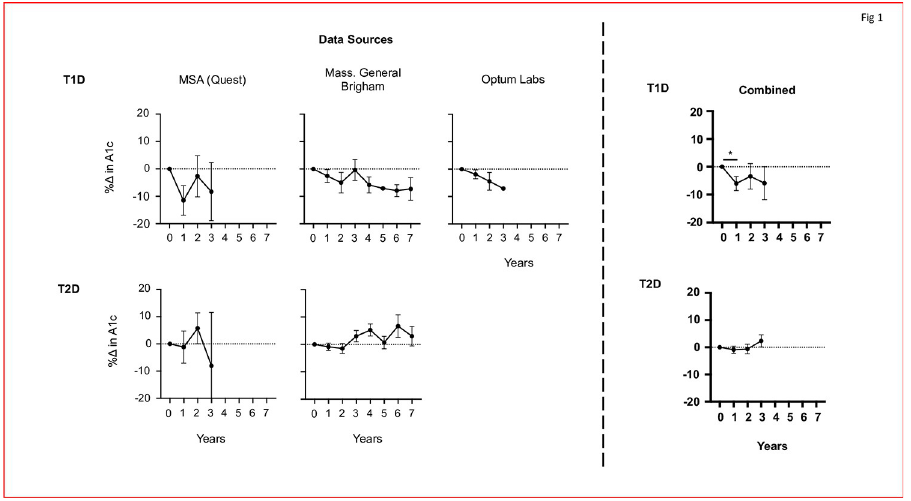
Fig 1. Lower HbA1cs are observed in Type 1, but not Type 2, diabetic subjects post-BCG treatment for bladder cancer. For T1Ds, all three datasets (MSA, RPDR and OL) show a reduction in HbA1c, calculated as percentage change in HbA1c values post-BCG instillation. Each dataset also shows a near 10% decrease in HbA1cs at differing time points. Combined, the data for T1Ds convey a statistically significant decrease in year 1 post-BCG instillation (p = 0.0304). In contrast, the MSA data for T2Ds show no change in the HbA1cs of patients, and the RPDR reveals an increase in HbA1c values post-BCG instillation. The combined data shows no significant change. N’s for each dataset: RPDR = 4, MSA = 9 and OL = 6 for T1Ds. And RPDR = 97, MSA = 9 for T2Ds.